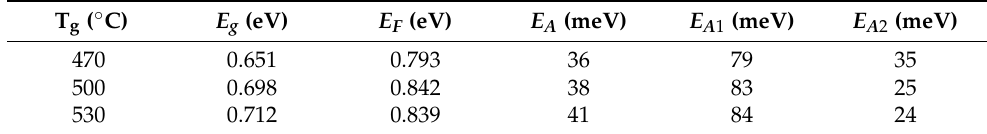
Table 2. Fitting results of the low-temperature PL